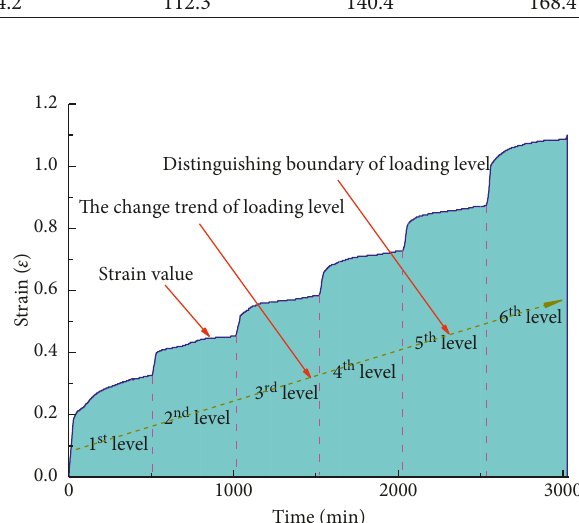
Figure 2: The change process of